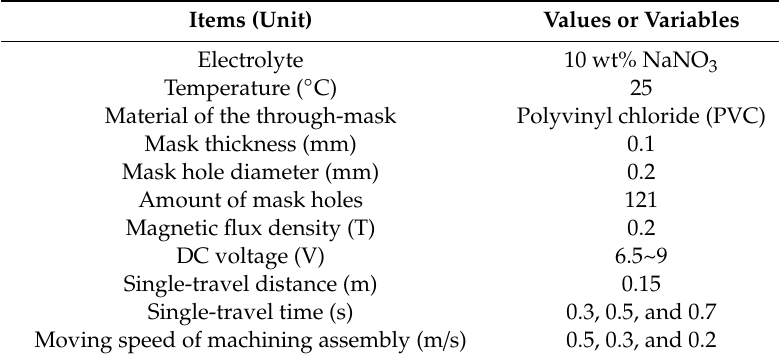
Table 1. Experimental conditions